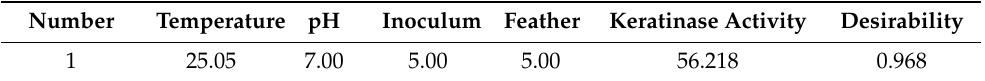
Table 6. Suggested value for each variable for optimum keratinase activity by Bacillus sp. strain